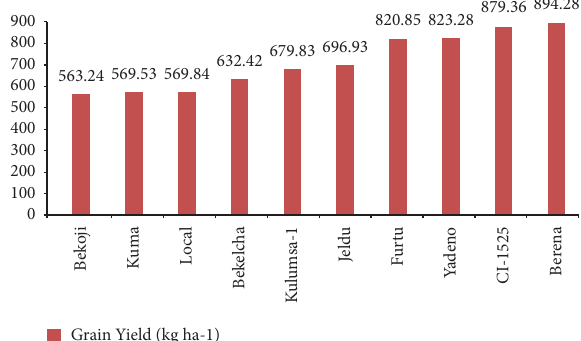
Figure 3: Comparative mean performance of seed yield combined over the two seasons (2019 and